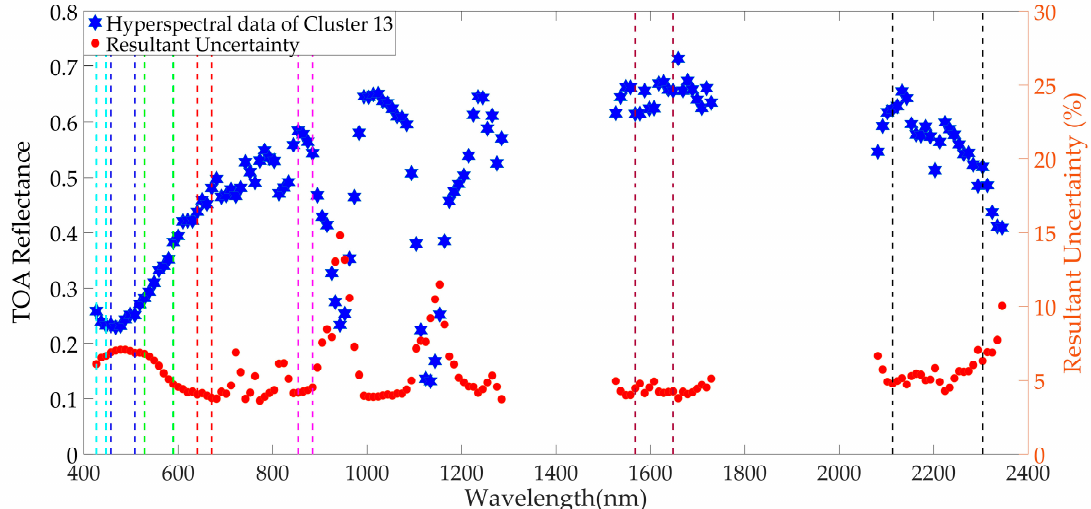
Figure 10. Estimated representative hyperspectral profile of Cluster 13 and its resultant uncertainty.